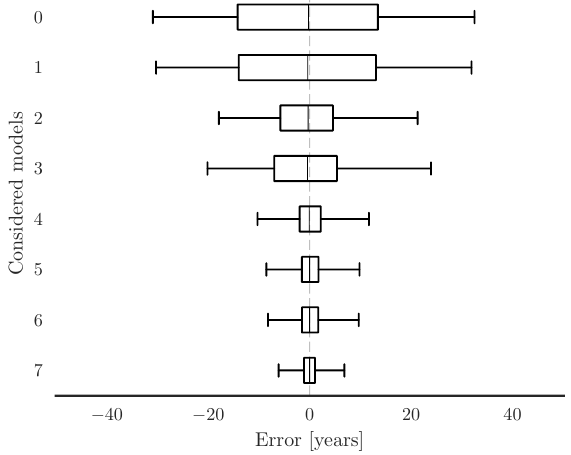
Figure 4. Distribution of errors for all models as box plots. The boxes span the interquartile range (the middle 50%). The line in- side the rectangle indicates the median, while the whiskers cover 80% of the errors (10th and 90th percentile).